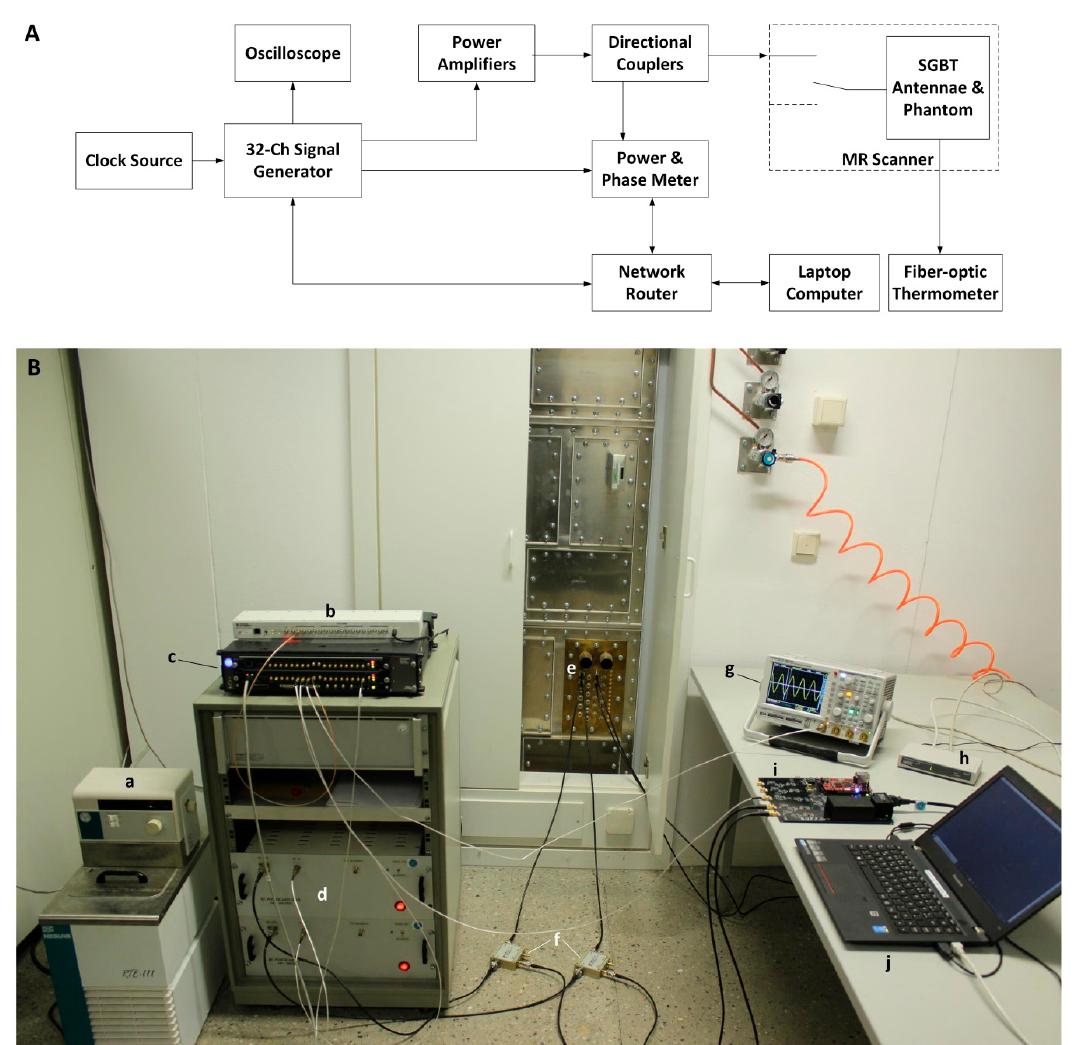
Figure 9. ( A ) Schematic of the experimental setup. Four RF signals were generated. One signal was connected to an oscilloscope for monitoring. Two signals were connected to RFPAs to drive the SGBT antennae and the last one was connected to the home-built power and phase meter as a reference signal. The forward coupled outputs of the directional couplers were fed to the power and phase meter. The signal generator, the power and phase meter and the laptop computer communicate with each other through network connections. ( B ) Setup used for the RF heating experiments comprising: ( a ) water cooling system, ( b ) clock distributor, ( c ) RF signal generator, ( d ) home-built RF power amplifiers, ( e ) penetration panel, ( f ) directional couplers, ( g ) oscilloscope, ( h ) network router, ( i ) home-built power and phase meter, ( j ) laptop for interacting with the equipment. The MR scanner and the fiber optic thermometer are not shown in the photo.